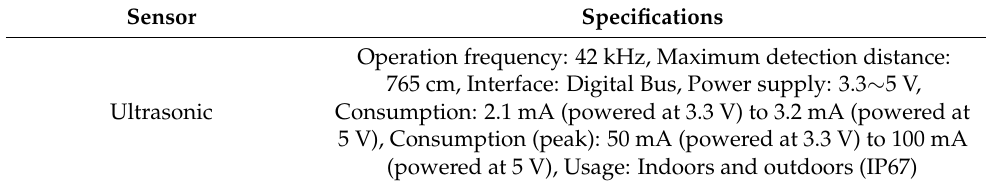
Table 3. Weather station sensors